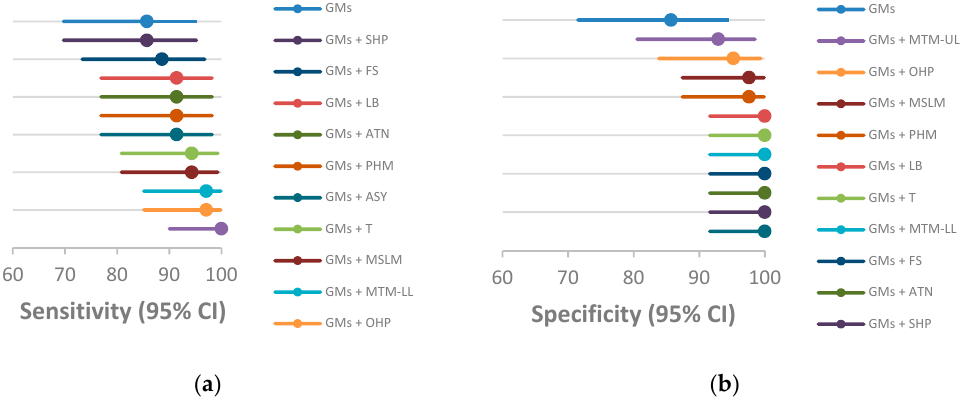
Figure 2. Sensitivity ( a ) and specificity ( b ) of GMs trajectories alone and in combination with concomitant motor and postural patterns trajectories. LB = signs pointing to loss of balance, T = tremors, MTM-UL = movements towards midline in upper limbs, MTM-LL = movements towards midline in lower limbs, OHP = open hand posture, FS = finger spreading, MSML = monotonous/stereotyped limbs movements, ATN = asymmetric tonic neck posture, HPS = head posture on a side, PHM = pathological head movements, ASY = asymmetries.